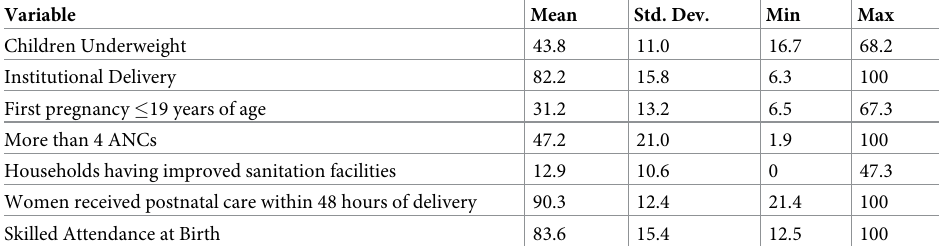
Table 2. Summary statistics of the selected dependant and independent variables. Block-level percentages, CCMII, 2014–15, Odisha, India.